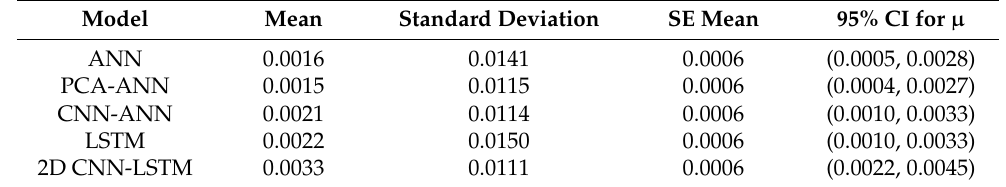
Table 12. Descriptive Statistics of Daily Brent Crude Oil Return’s with Five-Day-Ahead.